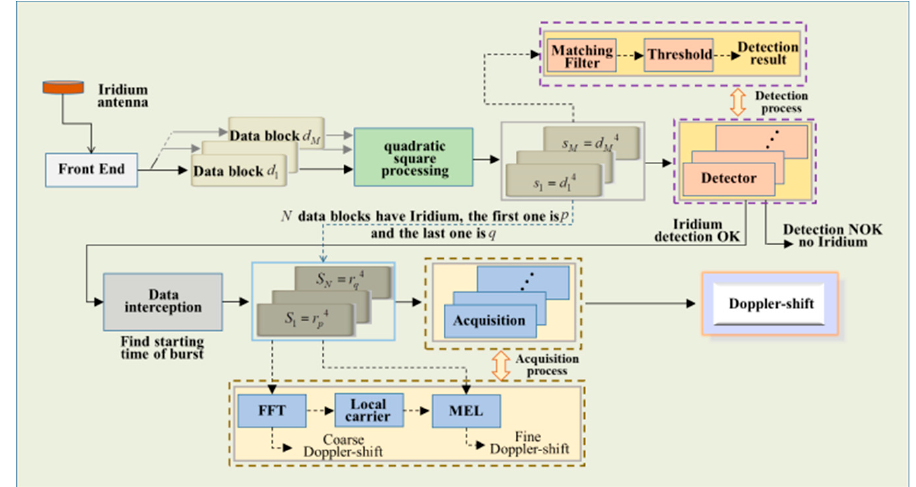
Figure 2. Principle of the quadratic square accumulating instantaneous Doppler estimation algorithm.